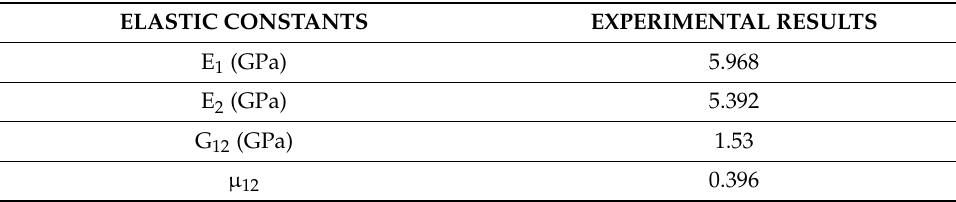
Table 5. Elastic constants of the WFBE composite lamina.